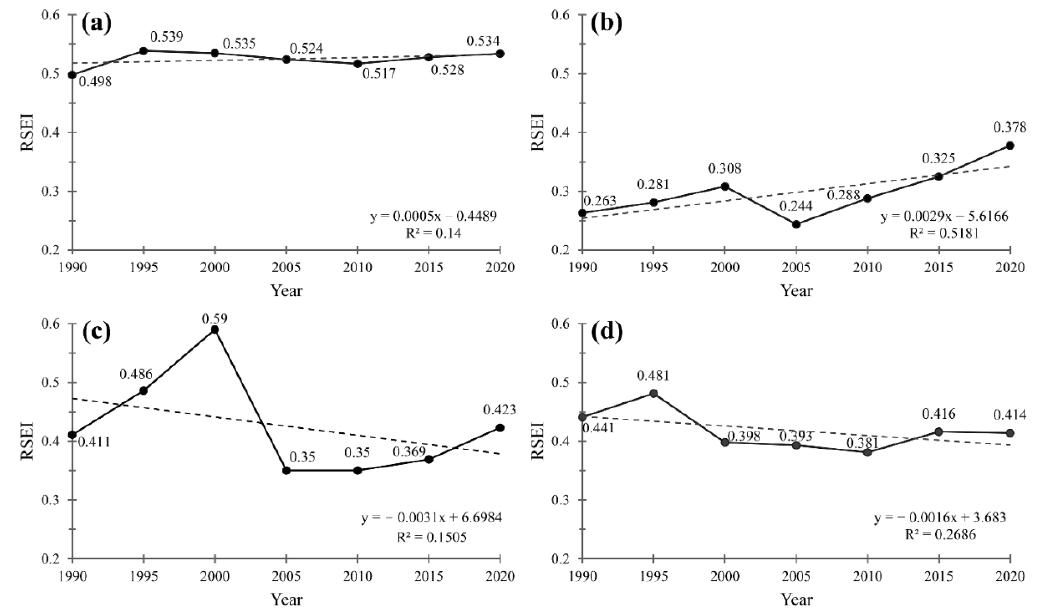
Figure 4. 1990 – 2020 RSEI Mean Line Graph ( a ): Panzhihua, ( b ): Zhulan Mine, ( c ): Baima Mine, ( d ): Panjiatian Mine).